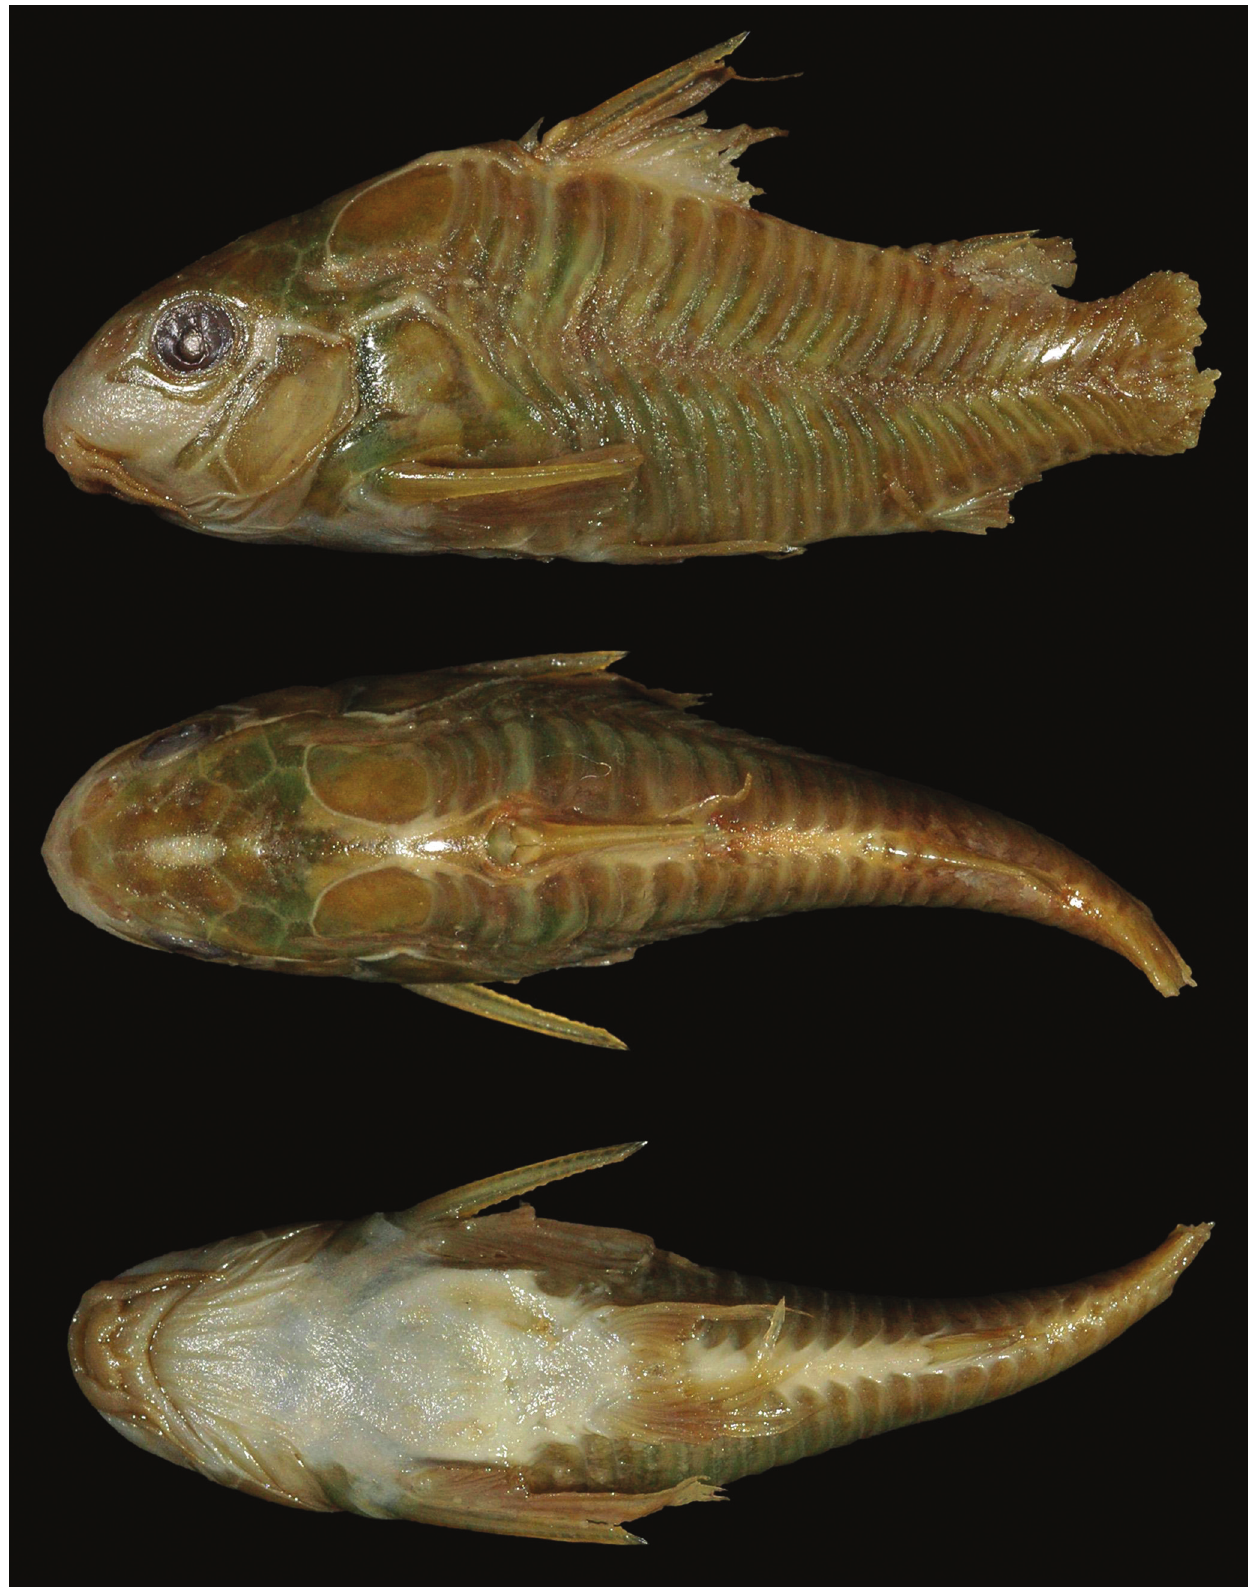
Fig. 1. Lectotype of Callichthys paleatus , BMNH 1917.7.14.18, 1, 31.0 mm SL, uncertain locality, collected by Charles Darwin between the years of 1832-1836. Lateral, dorsal and ventral views. Photo by Mark Allen, copyright Natural History Museum,